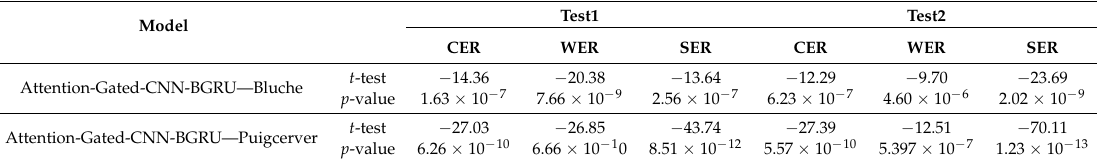
Table 4. A comparison of the recall (i.e., sensitivity) of the CER, WER, and SER for test1 and test2. To verify whether our proposed model achieves statistically significant improvements in the sensitivity of reducing the errors, the paired t-test is conducted with the confidence of 95% ( p -value < 0.05). Test1 Test2 Model